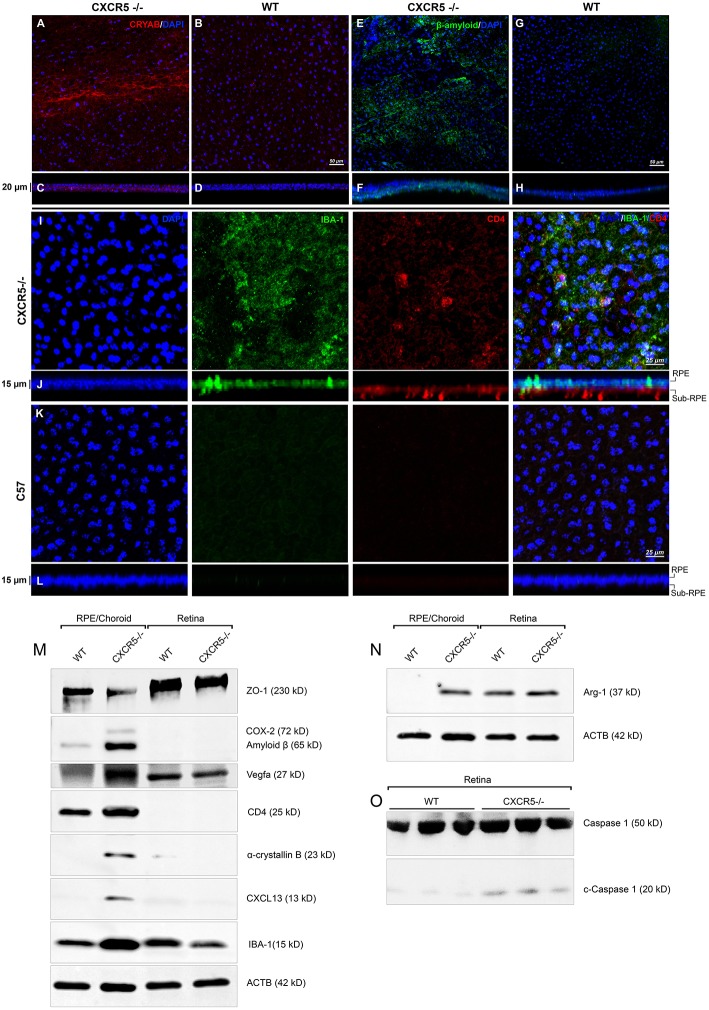
Immunofluorescent analysis of RPE/choroidal flat mounts and western blot analysis of RPE/Choroid and retinal material. Alpha-crystallin B (red) immunofluorescent staining in RPE/choroidal complexes. (A) Strong Alpha-crystallin B signals were detected in CXCR5−/− animals; (B,D) noise levels of red fluorescence were detected in WT controls; z-stack depth analysis in (C) CXCR5−/− flat mounts indicate sub-RPE localization of the signals in CXCR5−/− RPE/choroidal complexes, forming a distinctive layer under the RPE cells. Marked amyloid beta (Aβ) staining (green) was detected in RPE/choroidal complexes in the (E) CXCR5−/− sub-RPE localization of Aβ was identified by (F) z-stack depth analysis, no amyloid beta expression detected in (G) WT animals and (H) it's z-stacks. CXCR5−/− mice also indicated an increased presence of IBA-1 (green) and CD4 (red) positive cells within the (I) RPE/choroidal complex; (J) z-stack analysis revealed the presence of IBA-1 positive signals on the surface of the RPE layer and sub-RPE localization of CD4 positive cells; (K,L) WT samples demonstrated minimal IBA-1 fluorescence and no CD4 positive cells. Nuclear counterstaining by DAPI (blue) in fluorescent images. Protein expression of (M) ZO-1, COX-2, CD4, Cryab, CXCL13, and VEGF-a; (N) Arg-1, expression CXCR5−/− and age-matched WT control RPE/choroid and retina lysate. β-Actin used as a loading control. (O) Cleavage of Caspase-1 in retina lysate of CXCR5−/− and age-matched WT control animals. All samples were obtained from 24 m.o. female mice.